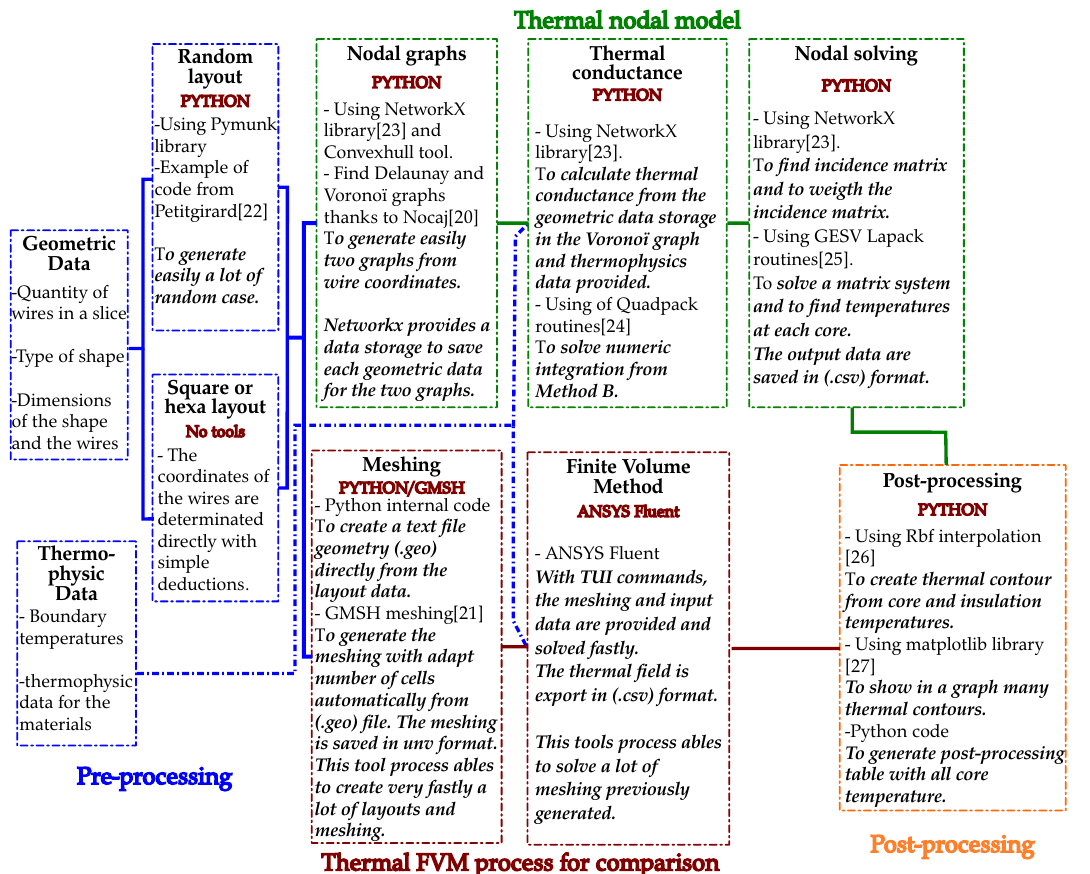
Figure 9. Software, programs and codes used to implement models, methods and comparison. All the contours of the nodal model results are obtained with a radial basis function (Rbf) interpolation [26] on a sufficiently refined grid. The Rbf interpolation is directly available in S CIPY library and could be easily plotted via the M ATPLOTLIB library